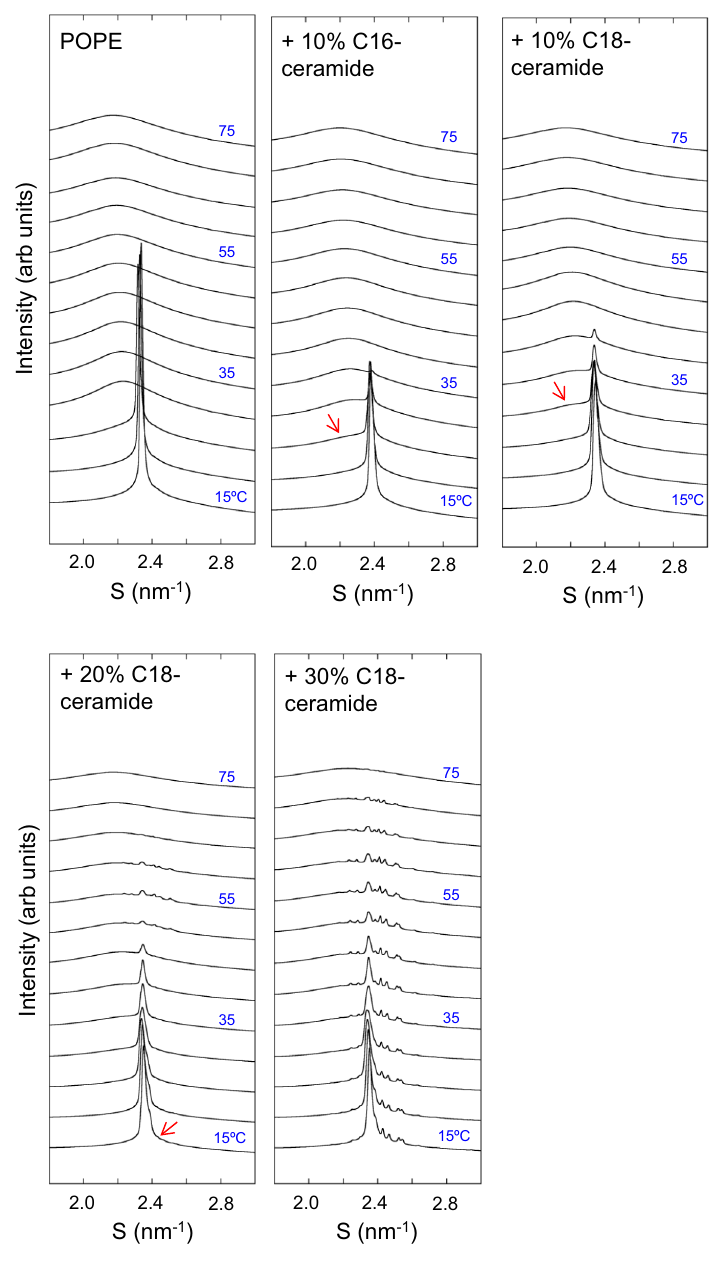
Figure 5. Wide-angle X-ray scattering (WAXS) profiles obtained from POPE, POPE/10% C16-ceramide and POPE/C18-ceramide containing different amounts of C18-ceramide (10, 20, 30 mol%). Data were taken from 15 to 75 °C at 5° interval. All samples (150 mM final lipid concentration) were dispersed in 20 mM HEPES buffer (pH 7.0) containing 100 mM NaCl and 10 mM